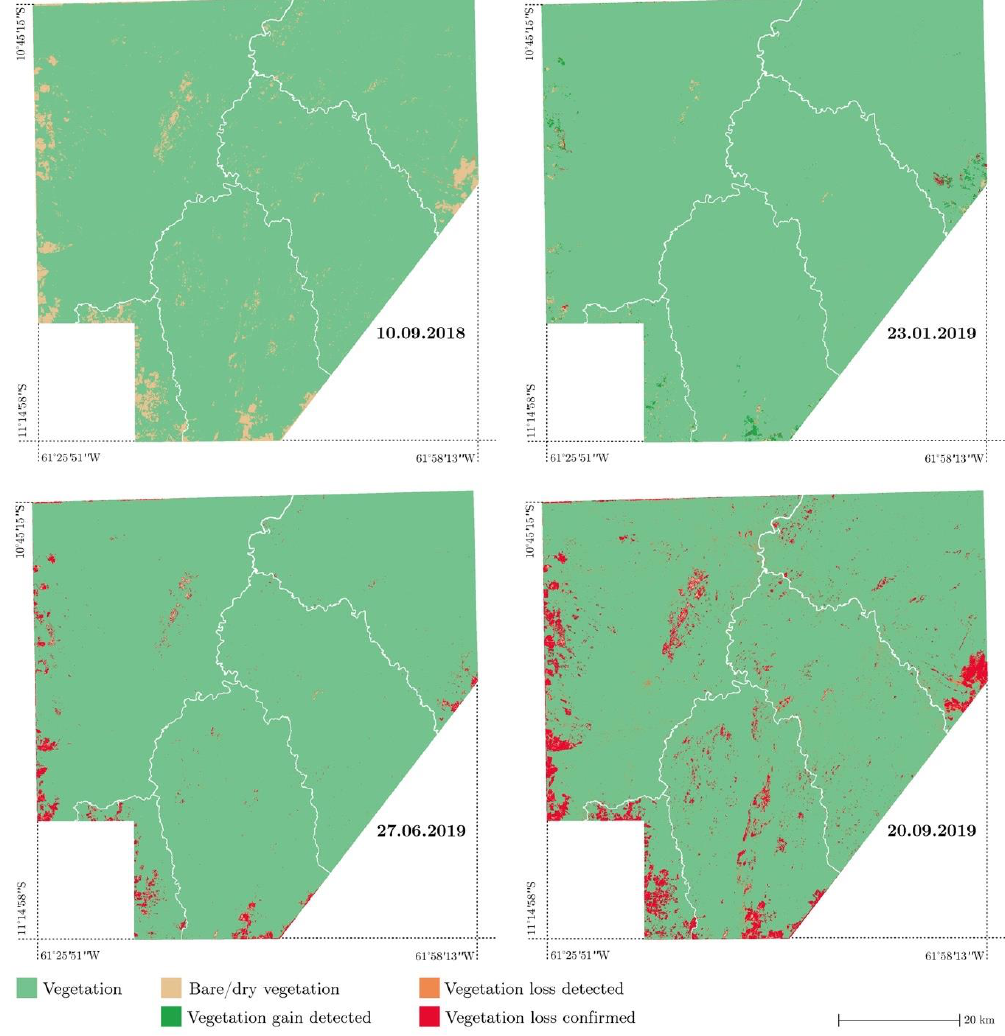
Figure 13. Maps of the vegetation loss and gain for the entire study area from September 2018 to September 2019.